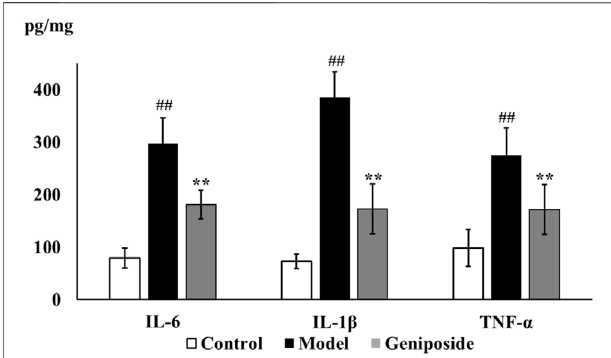
FIGURE 4 | Geniposide treatment improved in fl ammatory response in liver fi brosis model mice. ELISA test showed that geniposide treatment decreased the levels of IL-6, IL-1 β , and TNF- α in liver tissue homogenate. Control, model, and geniposide groups ( n (cid:2) 10 per group). ## p < 0.01, Model group vs. Control group; p p < 0.05 and pp p < 0.01, Geniposide group vs. Model group.